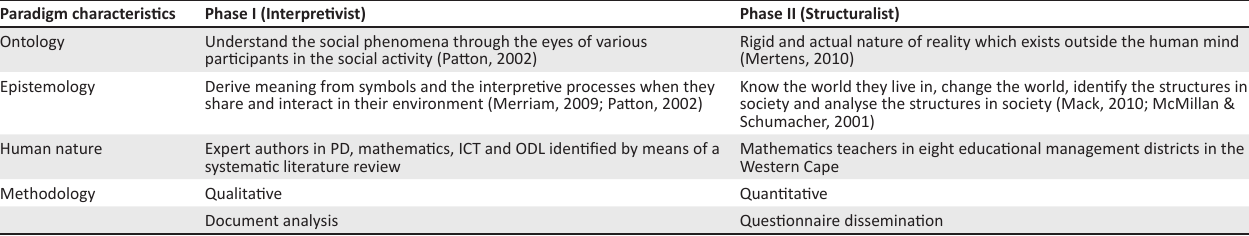
TABLE 1: Two phases of the multi-mode research. Paradigm